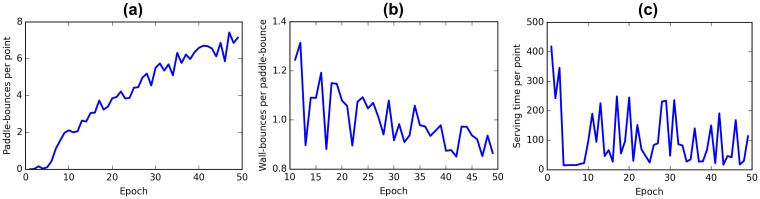
Evolution of the behavior of the competitive agents during training.(a) The number of paddle-bounces increases indicating that the players get better at catching the ball. (b) The frequency of the ball hitting the upper and lower walls decreases slowly with training. The first 10 epochs are omitted from the plot as very few paddle-bounces were made by the agents and the metric was very noisy. (c) Serving time decreases abruptly in early stages of training- the agents learn to put the ball back into play. Serving time is measured in frames.